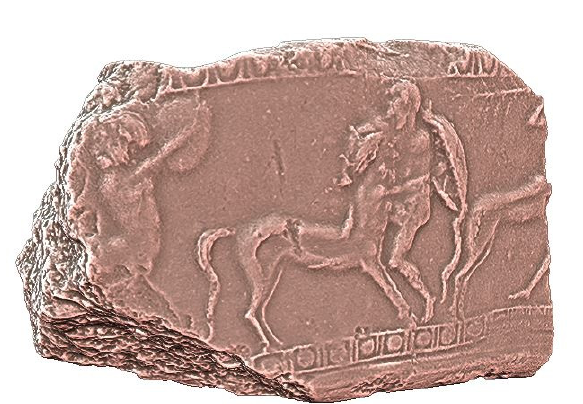
Figure 20. Digital visualization of the fragment with Centauromachia scene.